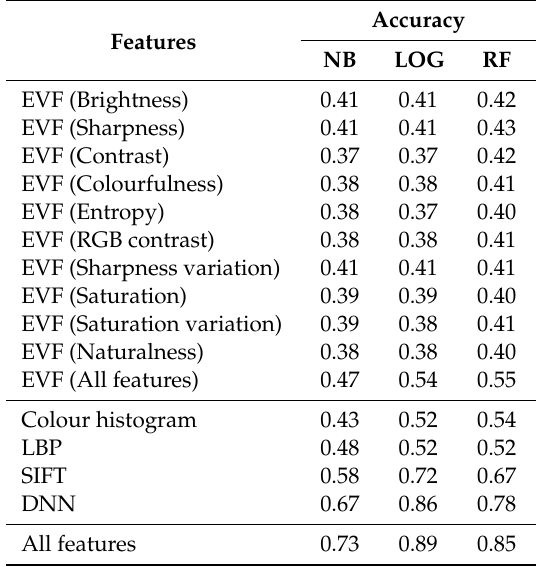
Table 2. Prediction accuracy for recipe source di ff erent visually related feature sets. Best performing scores for each classifier are bolded. NB = naive Bayes; LOG = logistic regression; RF = random forest; EVF = explicit visual features; LBP = local binary patterns; SIFT = scale-invariant feature transform; DNN = deep neural